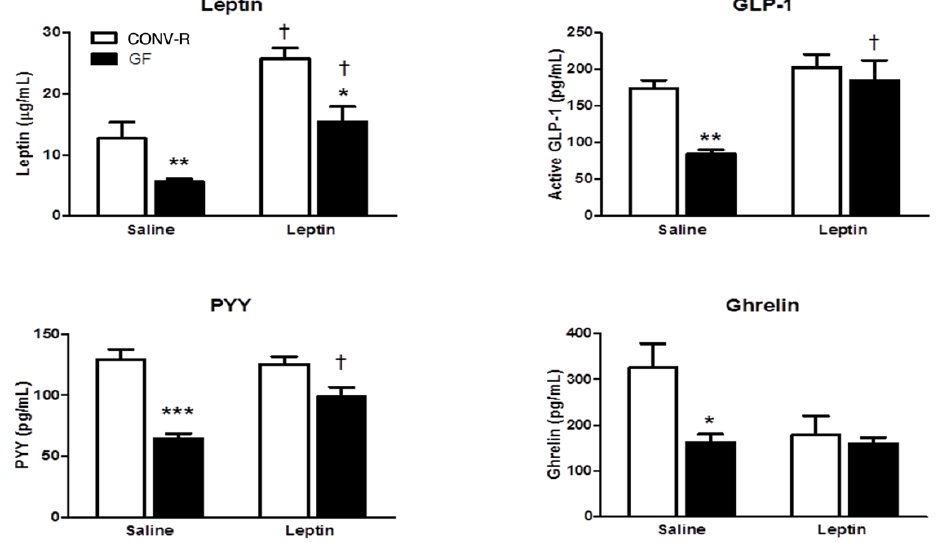
Figure 4. Gut peptide (leptin, GLP-1, PYY, and ghrelin) and leptin response to leptin injection in GF and CONV-R mice. Data are expressed as means ± SEM. * denotes statistical difference between GF and CONV-R. * p < 0.05, ** p < 0.01, *** p < 0.001. † denotes difference between phenotype and within treatment, † p < 0.05.